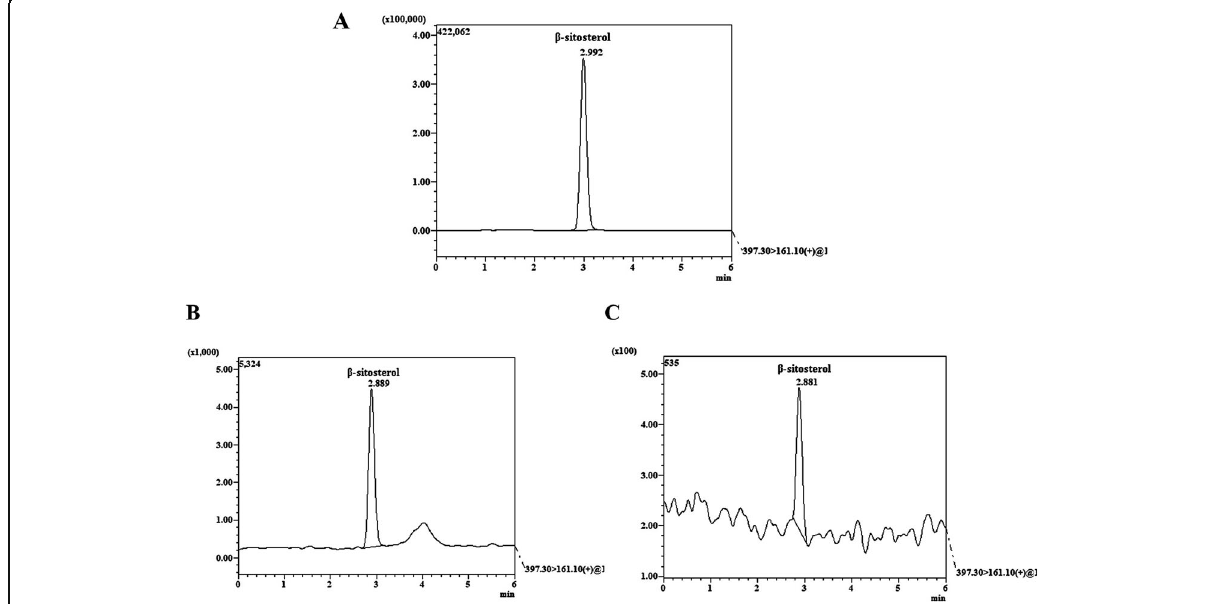
Fig. 1 LCMS/MS analysis of saw palmetto extracts. a Standard β -sitosterol, b VISPO and c SPO